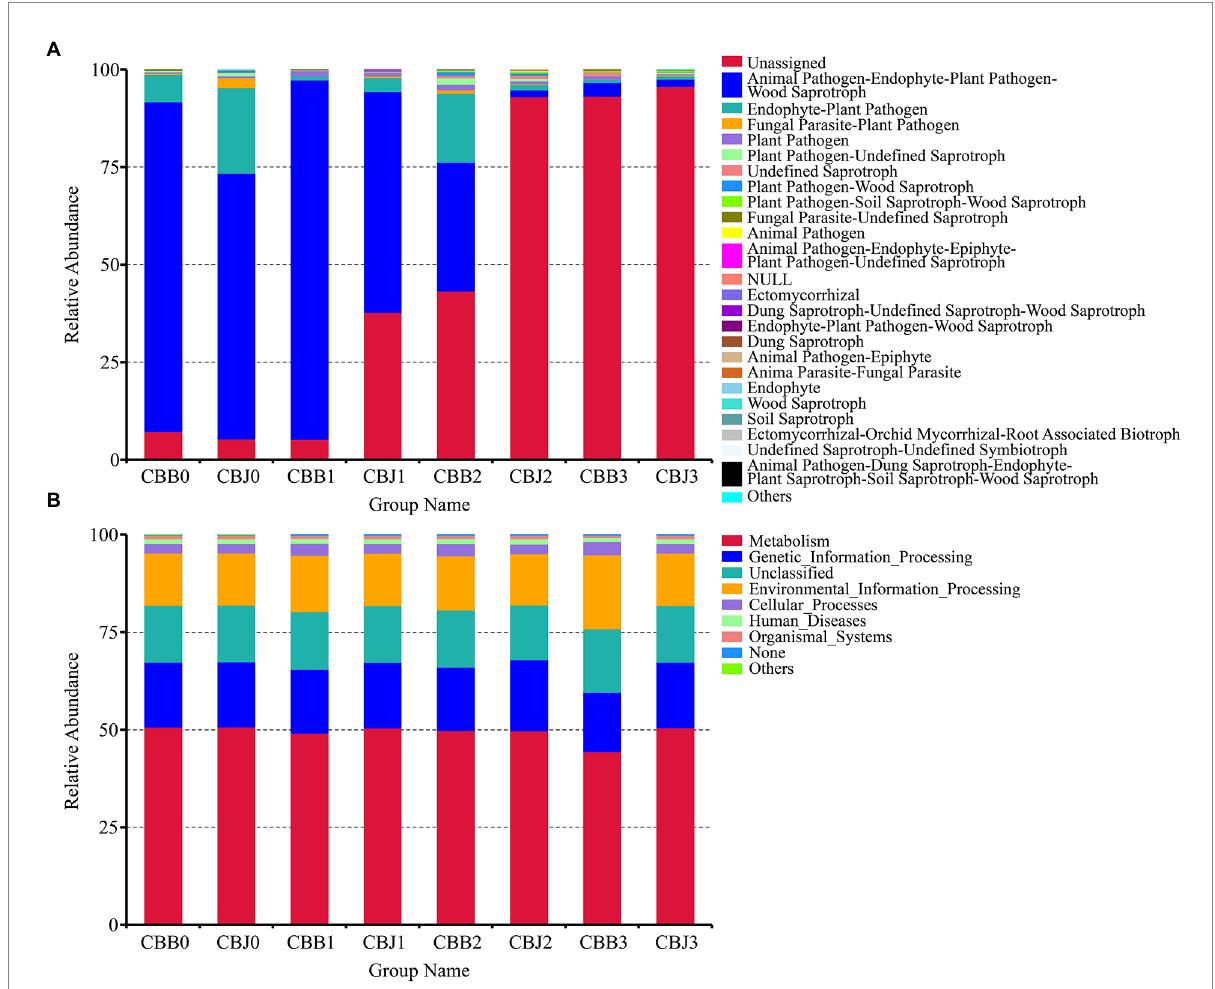
FIGURE 8 Microbial functional categories of tobacco leaves (symptomatic leaves CBB; asymptomatic leaves CBJ) at four sampling time points (0–3). (A) For fungal communities and (B) for bacterial